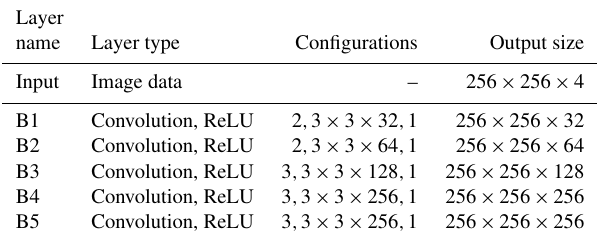
Table 1. Detailed configuration of the encoder in the proposed HCHNet method. ( l , k × k × n , s ) of configurations means there are l convolution layers with n convolution kernels, and their size is k × k and stride is s . ( h,w,c ) of the output size means the output image or feature maps have a height of h , a width of w , and a channel